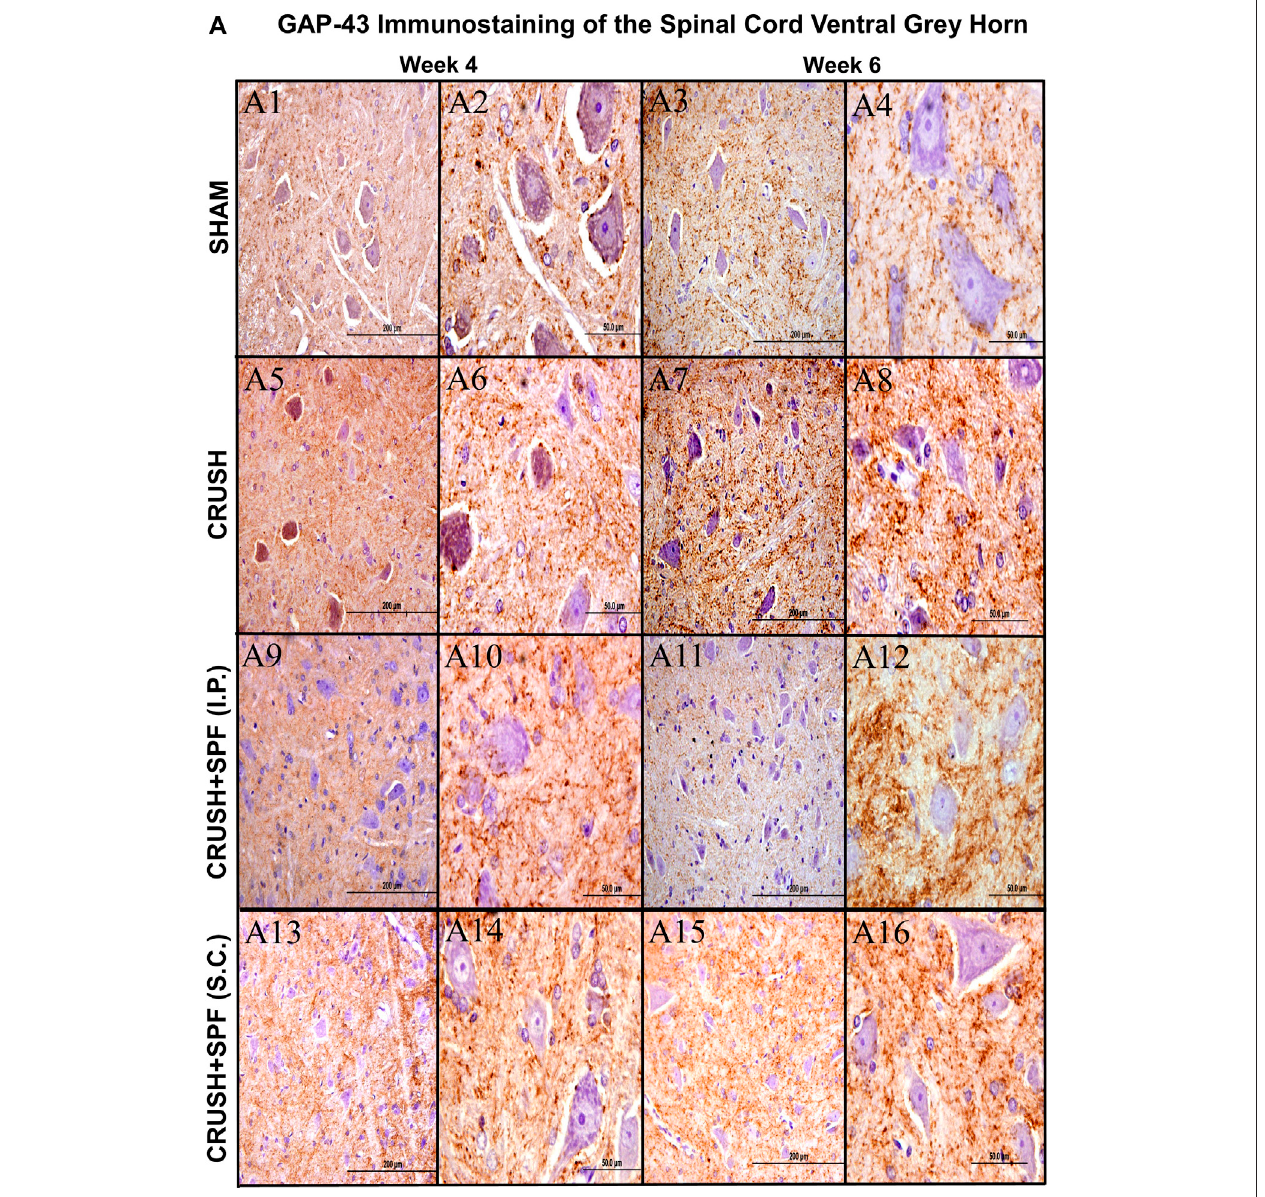
FIGURE10|(A) :Representative40 × and100 × photomicrographsoflumbarspinalcordventralgreyhornimmunostainedforGAP-43protein atweek4and week 6post-injury.NotetheincreaseintheintensityofGAP-43immunoreactivityintheCRUSHcomparedtoallexperimentalgroups.TheGAP-43immunoreactivitynumberis remarkably less in the CRUSH + SPF-FB(IP) and CRUSH + SPF-FB(S.C.)-treated animals compared to the saline-treated group. (B) : Bar graph shows the GAP-43 immunoreactiveintensityintheipsilateralventralgreyhornatweek4andweek6post-injury.Notesigni fi cantlyincreasedstainingintensityintheCRUSH,CRUSH+ 1X SPF-FB(IP), and CRUSH + 1X SPF-FB(S.C.) groups following nerve injury at Week 4. Whereas, IP and S.C SPF treatments signi fi cantly decreased the GAP-43 immunoreactivity at Week 6 post-injury. * indicates p < 0.001 SHAM vs. All groups; ¥ indicates p < 0.002 CRUSH vs. SHAM; indicates p < 0.01CRUSH+1XSPF-FB(S.C.)vs.SHAM;**indicates p < 0.03CRUSHvs.CRUSH+1XSPF-FB(IP)andCRUSH + 1X SPF-FB(S.C.). (C) : Bar graph shows the intensity of the GAP-43 immunoreactivity in the ipsilateral dorsal grey horn at week 4 and week 6 post-injury. Note signi fi cantly increased staining intensity in the CRUSH, CRUSH + 1X SPF-FB(IP) and CRUSH + 1X SPF-FB(S.C.) groups following nerve injury at Week 4. Whereas, IP SPF-FBtreatmentsigni fi cantlydecreased theGAP-43 immunoreactivity at Week 6post-injury. *indicates p < 0.0001SHAMvs. Allgroups; ¥indicates p < 0.02CRUSH vs. CRUSH +0.5X SPF-FB(IP) and CRUSH+ 1XSPF-FB(S.C.). (D) : Western blotanalysisofGAP-43 inthespinal cord atWeek 4 andWeek 6followingnerveinjury. (E) : Bargraphshowssigni fi cantlyincreasedGAP-43contentintheCRUSH,CRUSH+SPF-FB-treatedgroupscomparedtoNAÏVEandSHAMgroupsatWeek4andWeek 6 post-injury. However, IP and S.C. SPF-FB treatments signi fi cantly decreased the GAP-43 protein content in the spinal cord compared to CRUSH animals. * indicates p < 0.0001CRUSHvs.NAÏVEandSHAM;¥indicates p < 0.001CRUSHvs.0.5CRUSH+0.5XSPF-FB(IP);#indicates p < 0.02CRUSHvs.CRUSH+1XSPF-FB(S.C.); indicates p < 0.009 CRUSH vs. CRUSH + 2X SPF-FB(S.C.); α indicates p < 0.0001 NAÏVE and SHAM vs. All groups; ** indicates p < 0.048 CRUSH vs. CRUSH + 0.5X SPF-FB(IP).